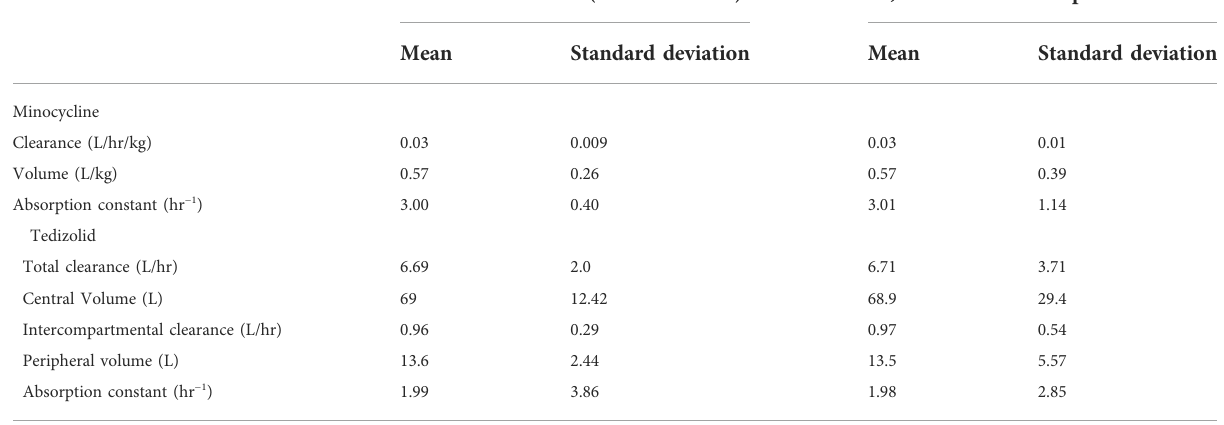
TABLE 4 Pharmacokinetic parameter input and output in Monte Carlo experiments.